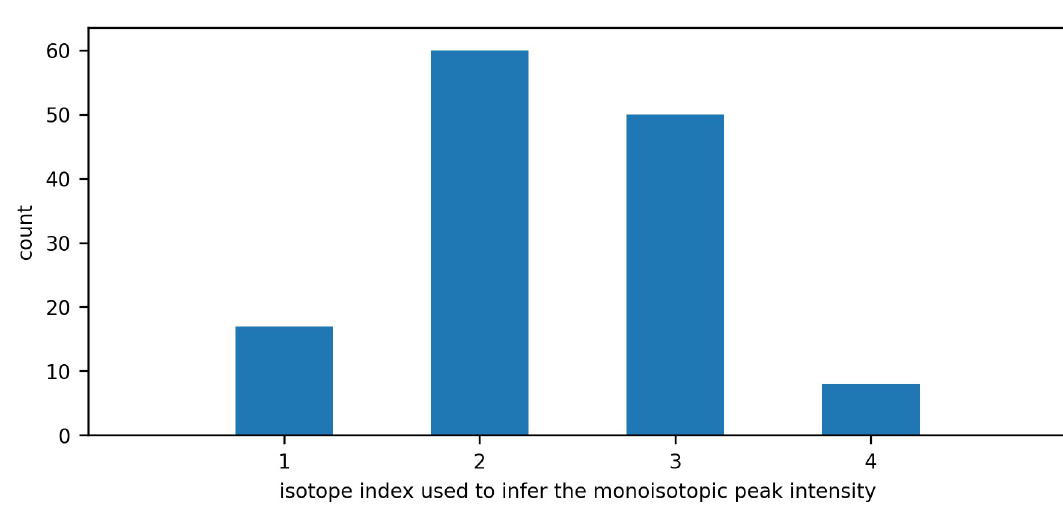
Fig 8. The distribution of isotope index used to infer the intensity of the monoisotopic